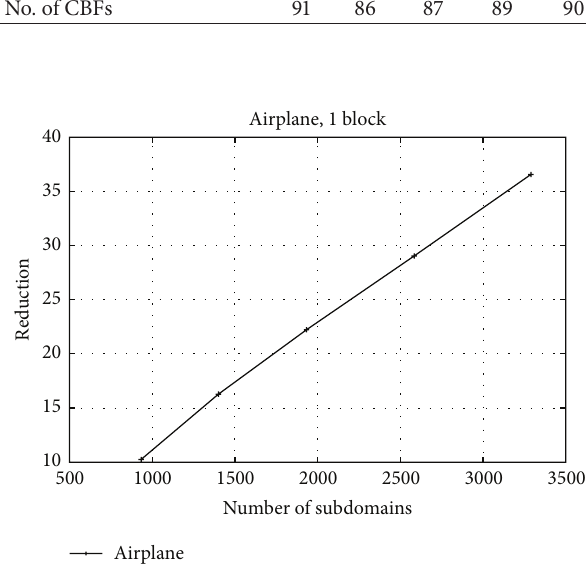
Figure 9: Reduction of problem size by the